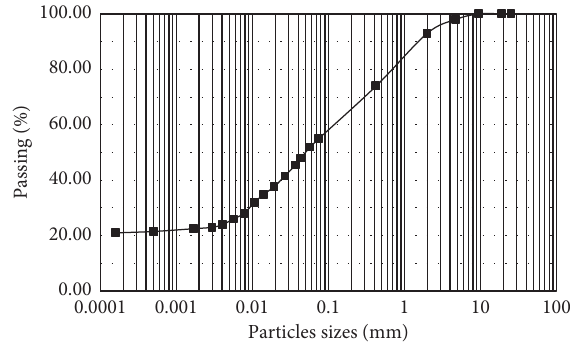
Figure 3: Grain size distribution curve of Karak expansive